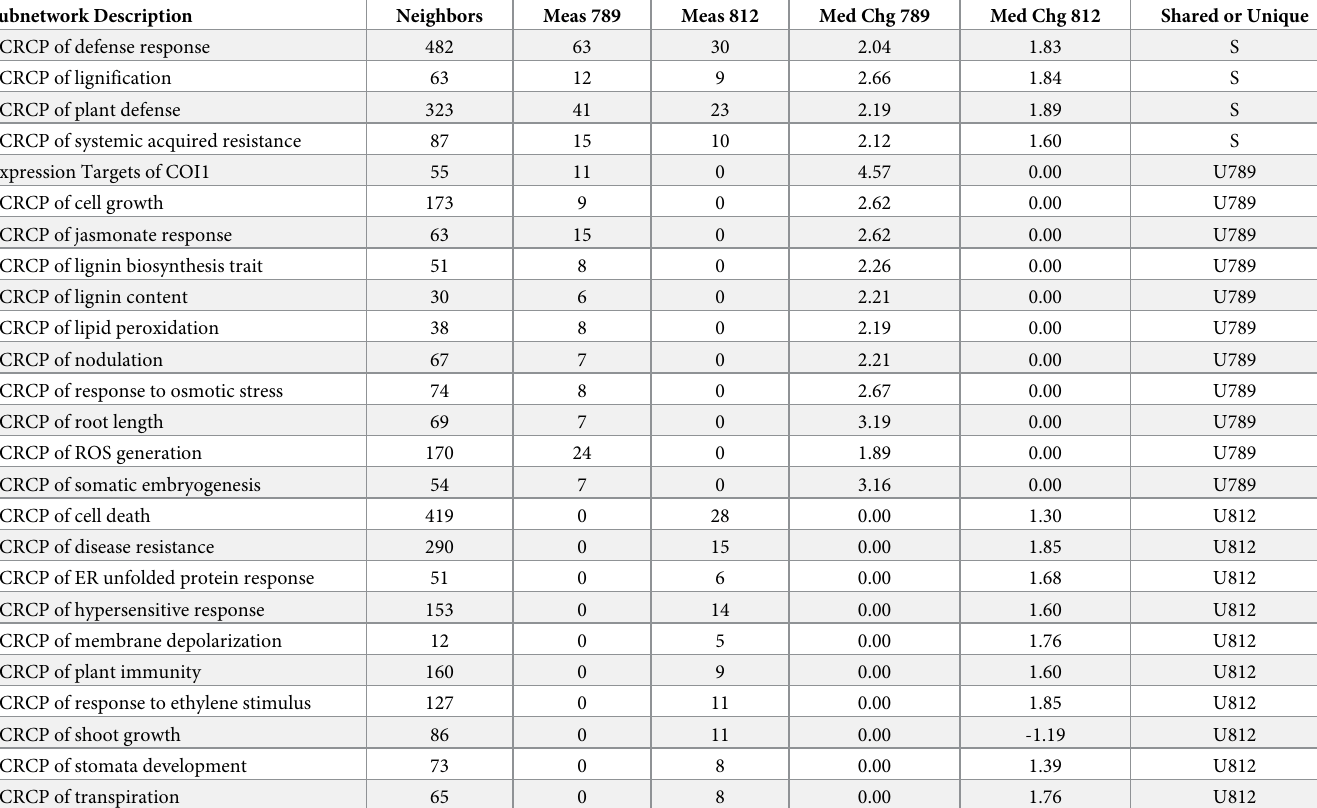
Table 7. Subnetworks overexpressed through significant genes in weed-stressed teosinte plants compared with weed-free